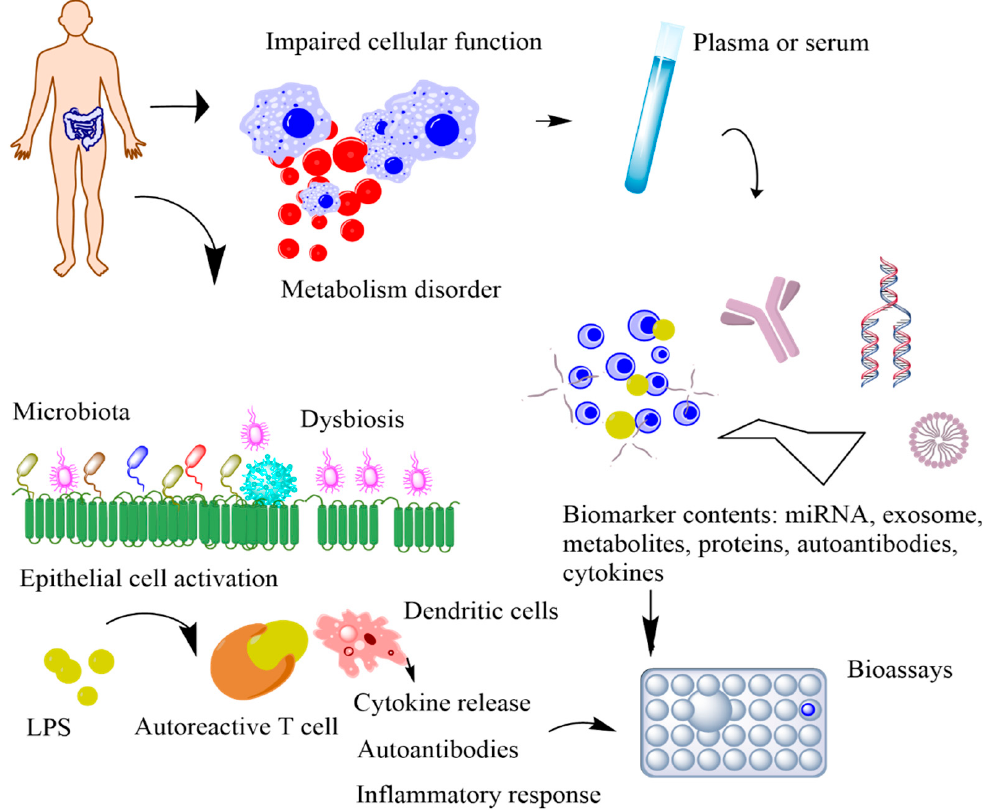
Figure 3. Schematic representation of the metabolic biomarkers released by impaired cellular functions and immune-gut microbiota interactions. In impaired cellular function, released biomarkers include exome, miRNA, cellular components, and antibodies. In immune–microbiome interactions, the intestinal dysbiosis and the increased bacterial lipopolysaccharides (LPS) trigger the autoimmune response, causing disease onset.